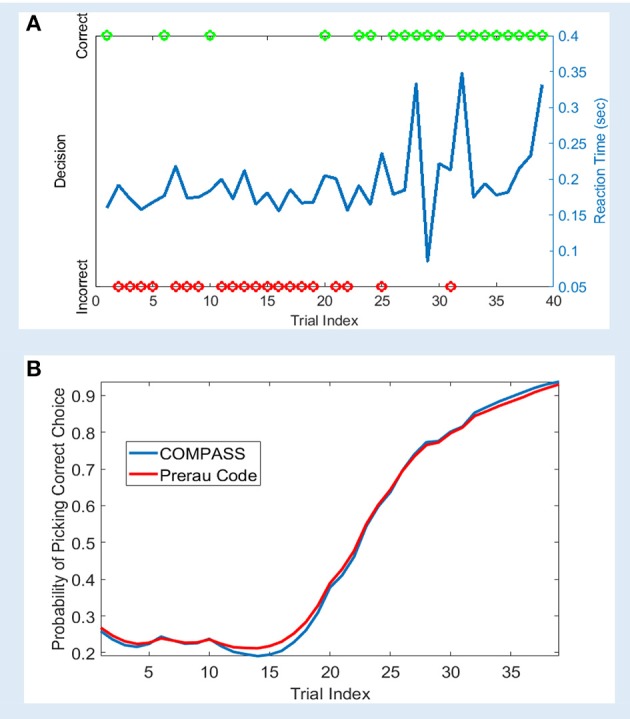
Sample learning behavior and learning state estimation using the method of Prerau et al. (2009) and COMPASS toolbox. (A) Correct (green) and incorrect (red) trial outcomes and reaction times (blue) over the course of a single task block. The behavior shows an abrupt change after 20 trials, with the subject beginning to match most stimuli correctly. The animal learns the task with an accuracy above 90% by the end of the trial block; the decision accuracy at the beginning of the block is < 30%. (B) The estimated learning curve using the Prerau code (red) and COMPASS toolbox (blue). The slight difference between the toolbox and Prerau et al. result relates to the different stopping criterion used in these methods. Prerau's method sets a preset threshold on the likelihood growth and stops when the likelihood growth falls below the threshold. In COMPASS, compass_em stops after a user-specified number of iterations.